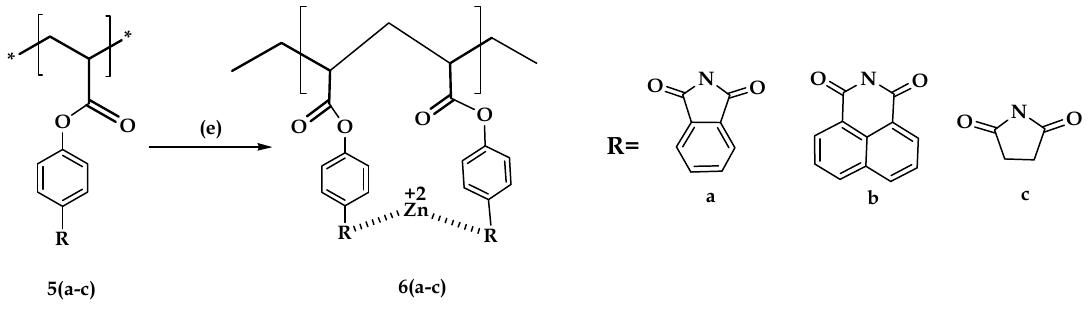
Figure 8. Reagents and conditions: (e) Zinc sulfate heptahydrate, CH 3 OH, THF, 20 min. Figure 8. Synthesis of zinc complexes of the imide derivative of polyacrylic acid 6a to 6c . Reagents and conditions: (e) Zinc sulfate heptahydrate, CH 3 OH, THF, 20